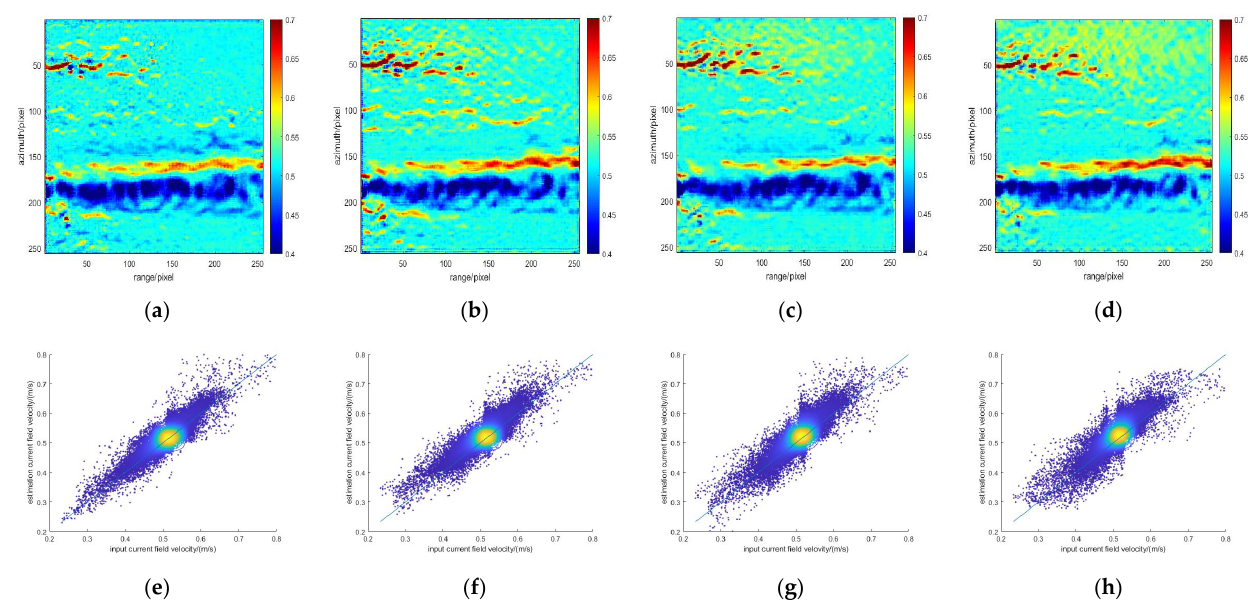
Figure 9. The estimation velocity of ocean surface currents under the different batch sizes from ( a – d ): ( a ) the batch size of 1, ( b ) the batch size of 2, ( c ) the batch size of 3, and ( d ) the batch size of 4. The scatter density map between the estimation